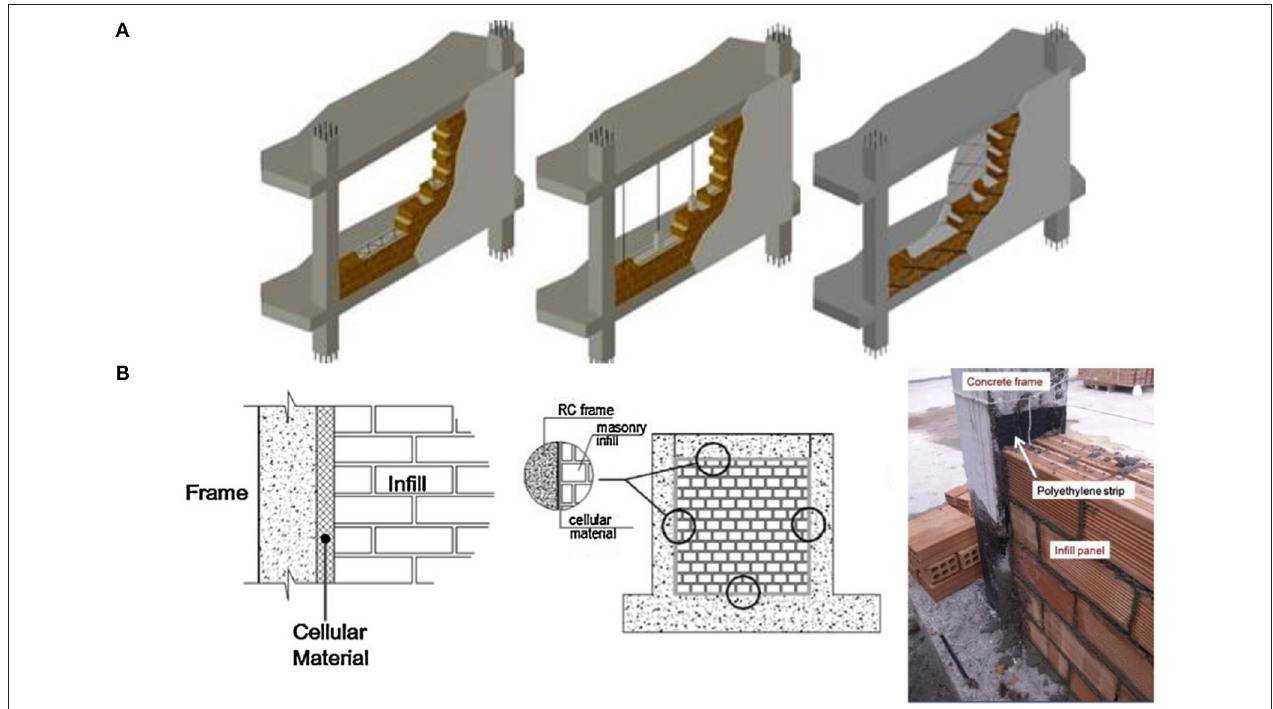
FIGURE 1 | (A) Solutions with enhanced in-plane/out-of-plane resistance (from Morandi et al., 2018); (B) “uncoupled” solution with flexible joints (Tsantilis and Triantafillou,